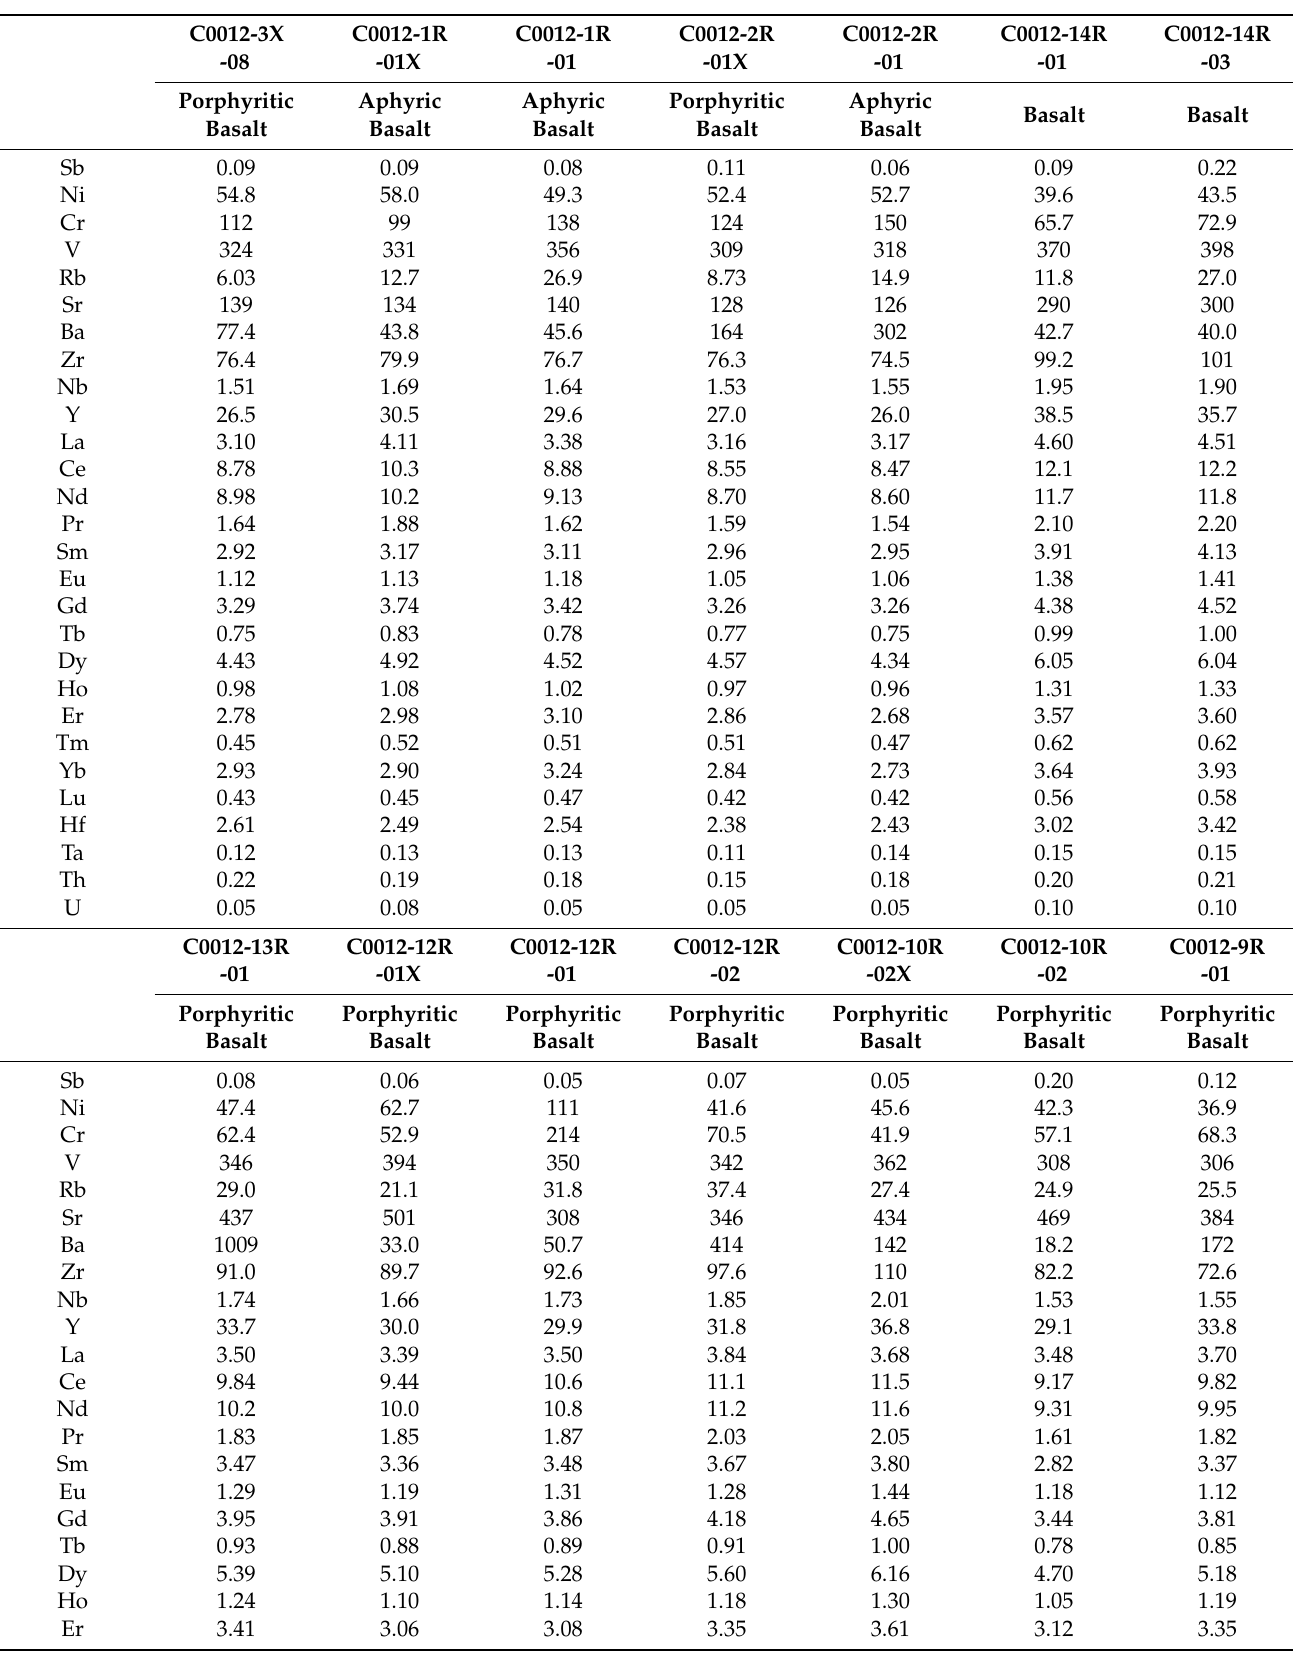
Table 2. Trace-element (ppm) concentrations of Site C0012 and Site 1173 volcanic rocks from the Shikoku